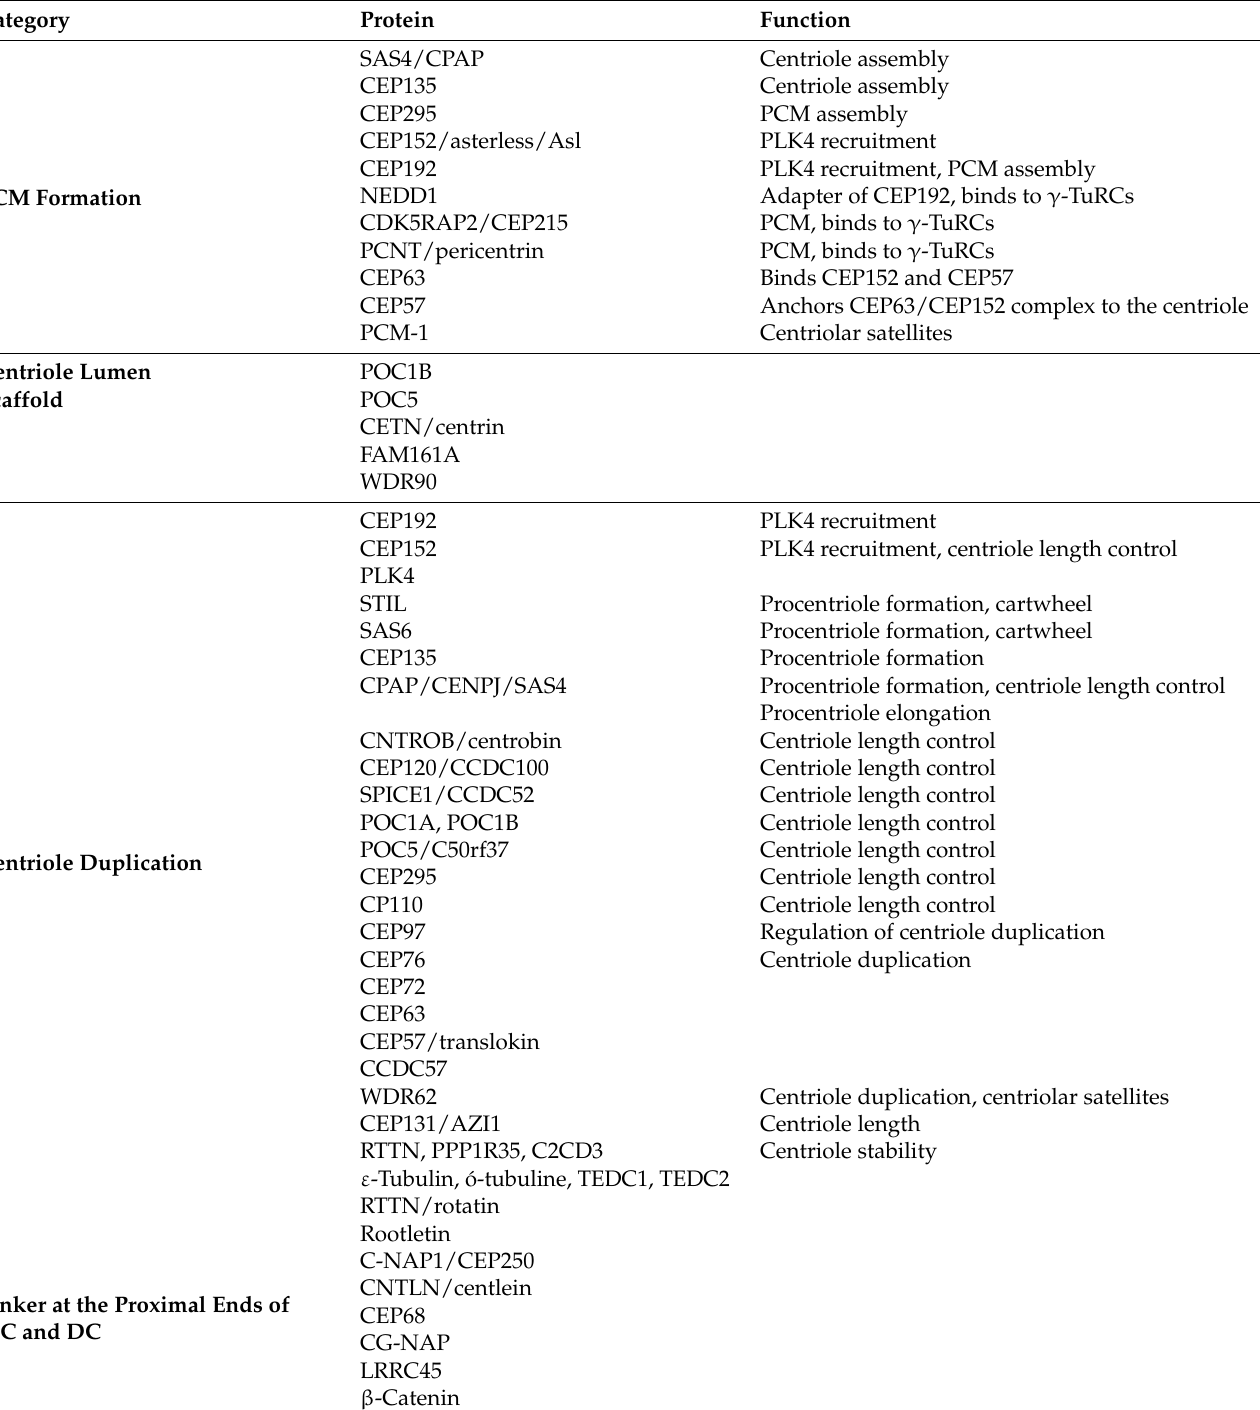
Table 1. Localization and function of characterized centrosomal proteins. Proteins relevant for cilia formation are largely excluded.